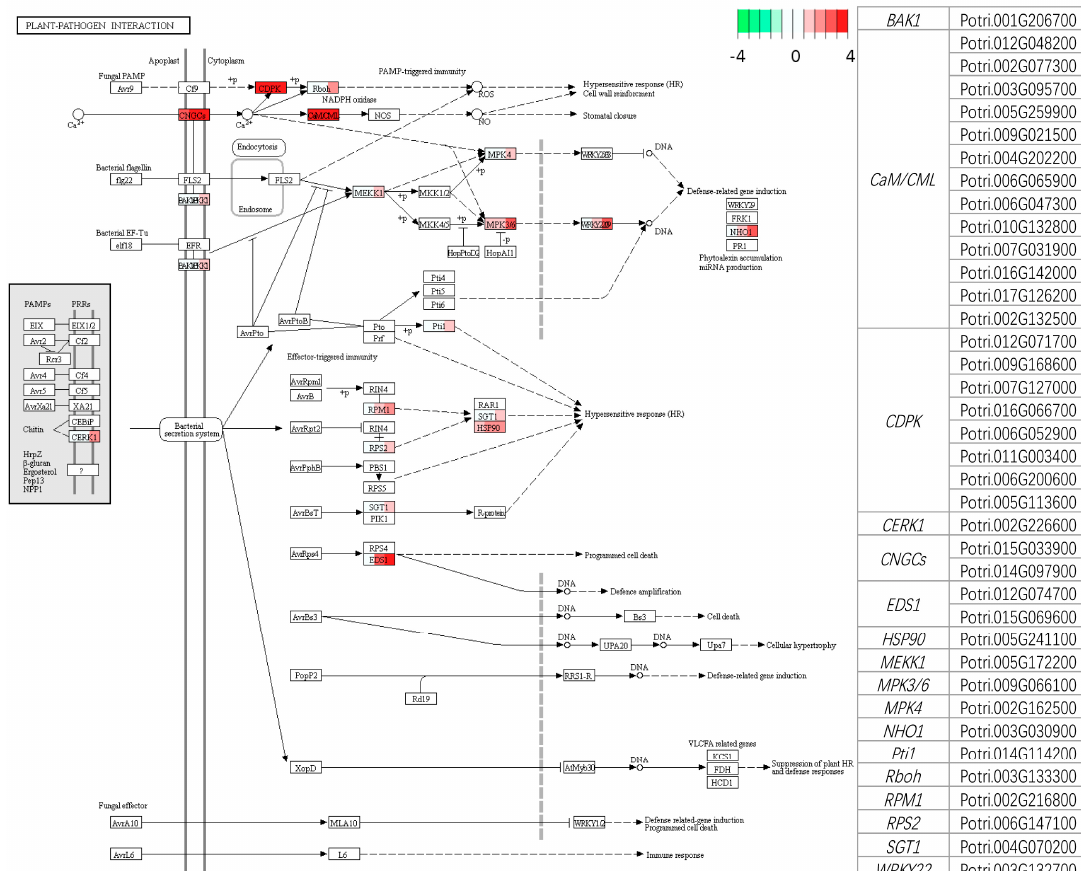
Figure 7. KEGG map (ko04626, plant-pathogen interaction) of Leu-MO45 infection system. The genes involved in plant-pathogen interaction were enriched by genes with uptrend expression in Leu based on clusterProfile, a R package. For each box, from left to right, contrasts 6hpi_vs_CK, 36hpi_vs_CK, and 96hpi_vs_CK, are depicted in color scale representing log 2 (fold change) values. The scale shows the value of log 2 (fold change) from − 4 (green) to +4 (red). The list on the right shows the detailed transcripts of Leu of each corresponding gene in KEGG map.